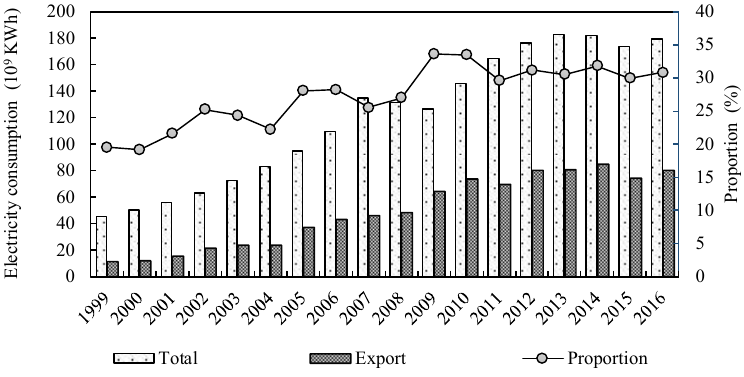
Figure 2. Distribution of electricity installed capacity in the Province of Shanxi, China in 2017.